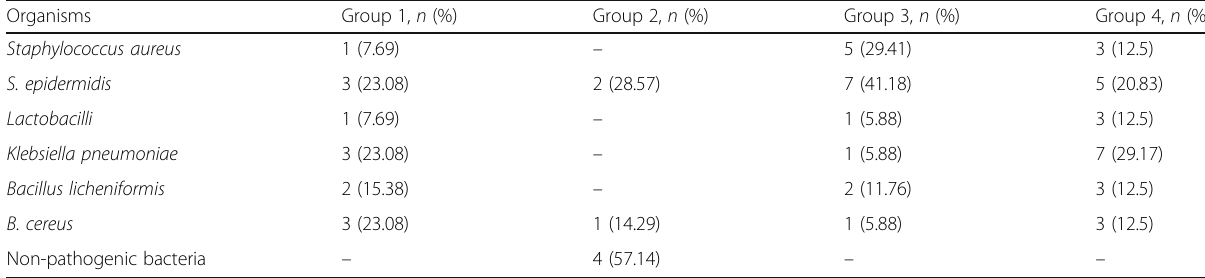
Table 3 Organisms isolated from the different groups Organisms